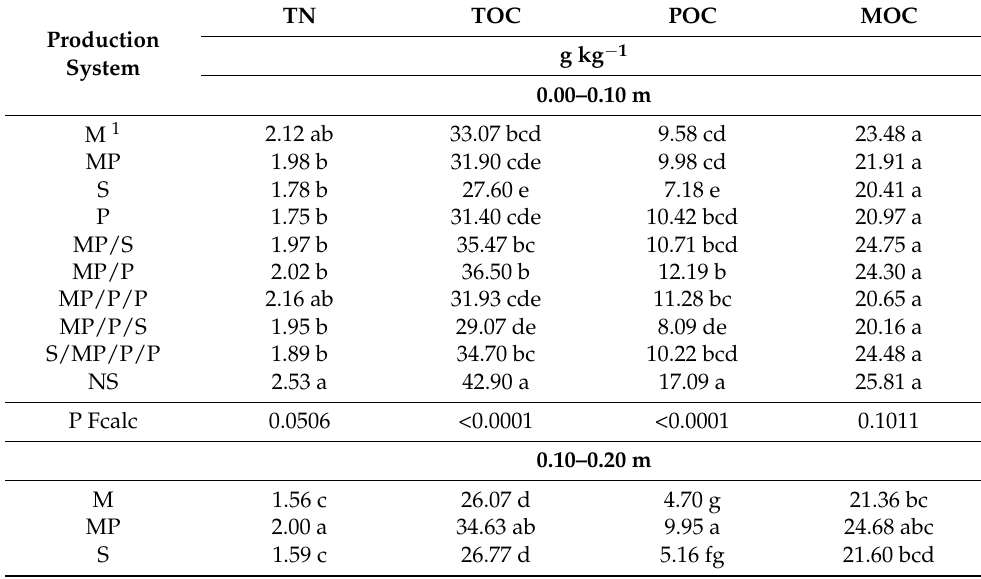
Table 3. Content of total nitrogen (TN), total organic carbon (TOC), particulate organic carbon (POC) and mineral-associated organic carbon (MOC) in layers 0.0–0.10, 0.10–0.20 and 0.20–0.40